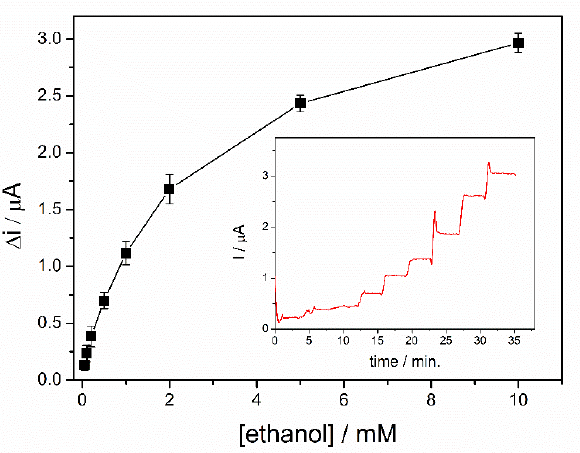
Figure 6. Dynamic response range of ADH-sol-gel/PAH/SPE biosensor (E = +500 mV, [NAD + ] = 10 mM, PBS 0.1 M pH = 8.8, n = 3) (inset: typical biosensor response curve).